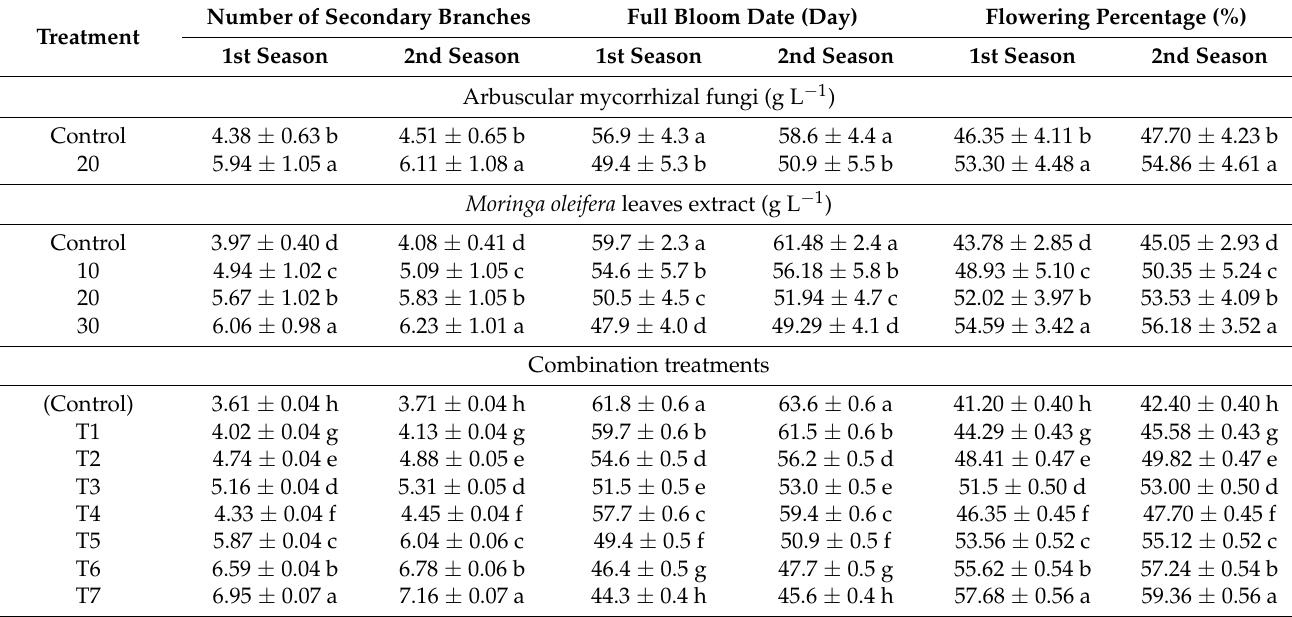
Table 6. The mean values of the number of secondary branches, full bloom date (day) and flowering percentage (%) of jojoba shrubs affected with ground inoculation of arbuscular mycorrhizal fungi and foliar application of Moringa oleifera leaves extract, as well as their combination treatments in both seasons of the